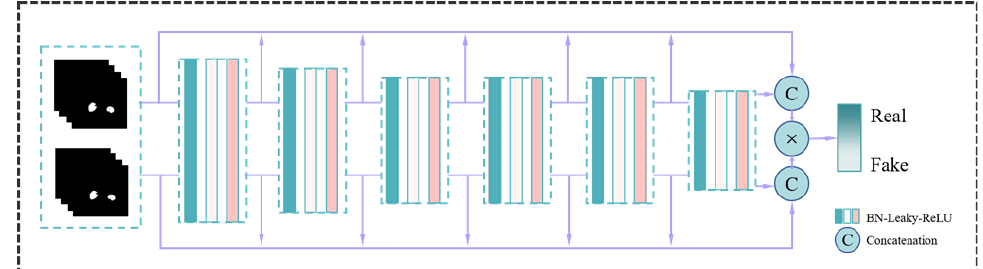
Figure 2. The structure of the discriminator network. The output is real or fake.